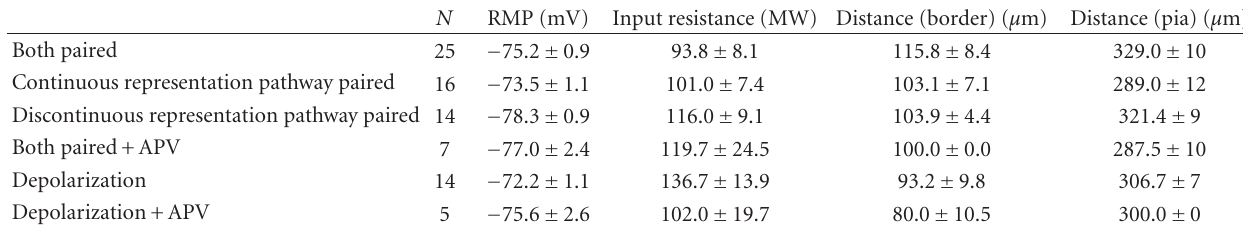
Table 1: Cell parameters for LTP.